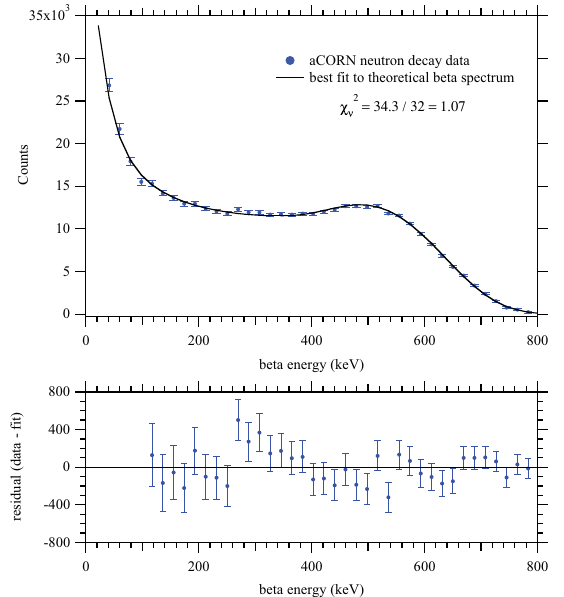
Figure 4. Top: The wishbone energy spectrum, a histogram of total wishbone events vs. beta energy, fit to the theoretical beta spectrum modified by the aCORN momentum acceptances. Bottom: Fit residuals. Error bars are statistical